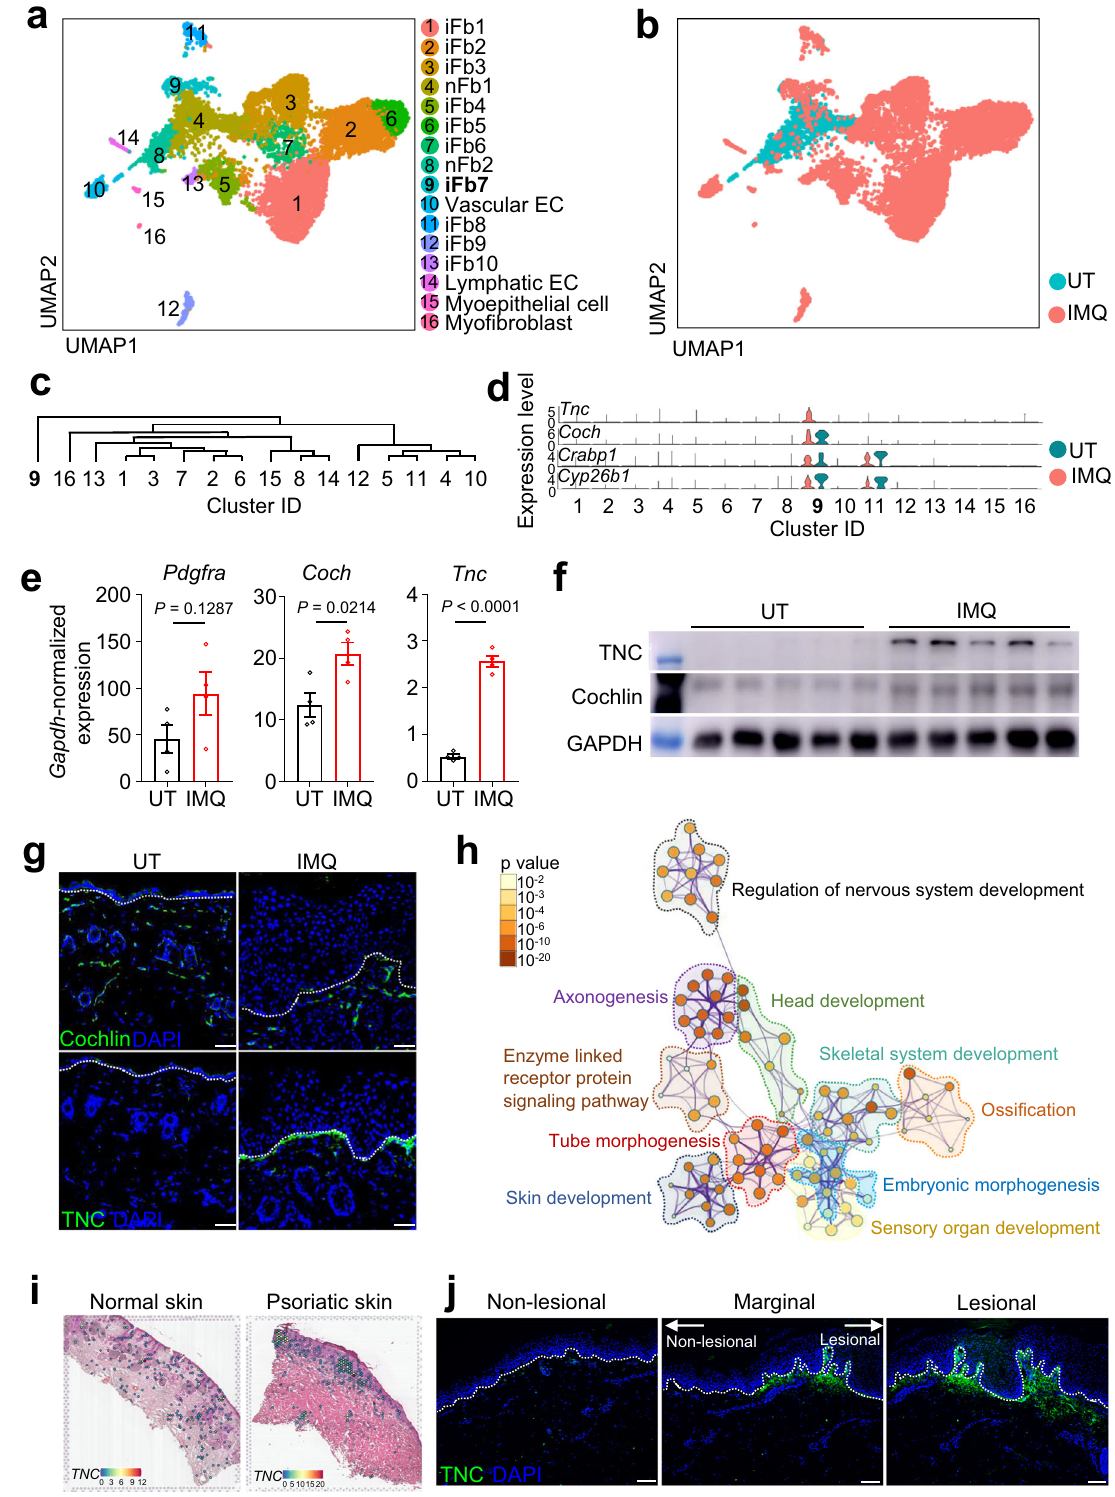
Fig. 2 | A tenascin-C (TNC)+ fi broblast subpopulation emerges at the dermal- epidermal junction (DEJ) of psoriatic skin. UMAP plot ( a, b ) and cluster den- drogram ( c ) of Pdgfra -lineage cells sorted from back skin of UT and IMQ-induced Pdgfra DreER -tdTomato mice. d Violin plots of cluster 9 signature genes expression. e qPCR analysis of Pdgfra , Coch , and Tnc in the dermis of UT or IMQ-induced mice ( n =4). f Immunoblot of Cochlin and TNC expression in the dermis of UT or IMQ- induced mice ( n =5). g Representative immuno fl uorescent images of Cochlin (upper panels) and TNC (lower panels) expression in UT or IMQ-induced mice